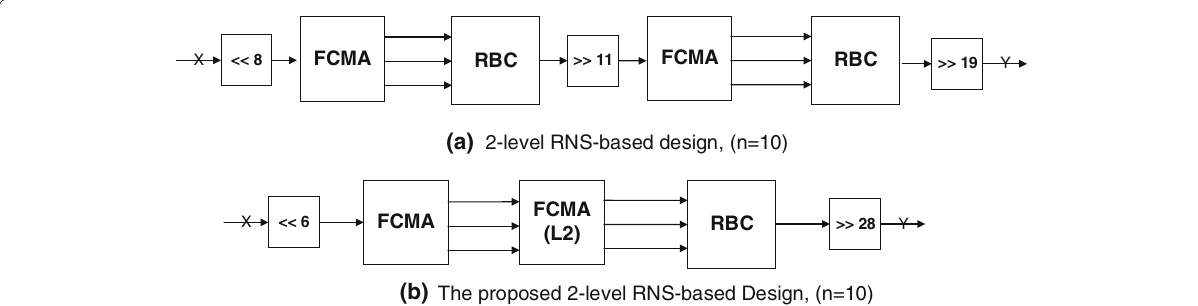
Fig. 7 The block diagram of two-level RNS-based DWT design ( a ), the full design with two RBCs, and ( b ) the proposed design, which eliminates the middle RBC to improve the latency. FCMA represents FIR filtering process in RNS